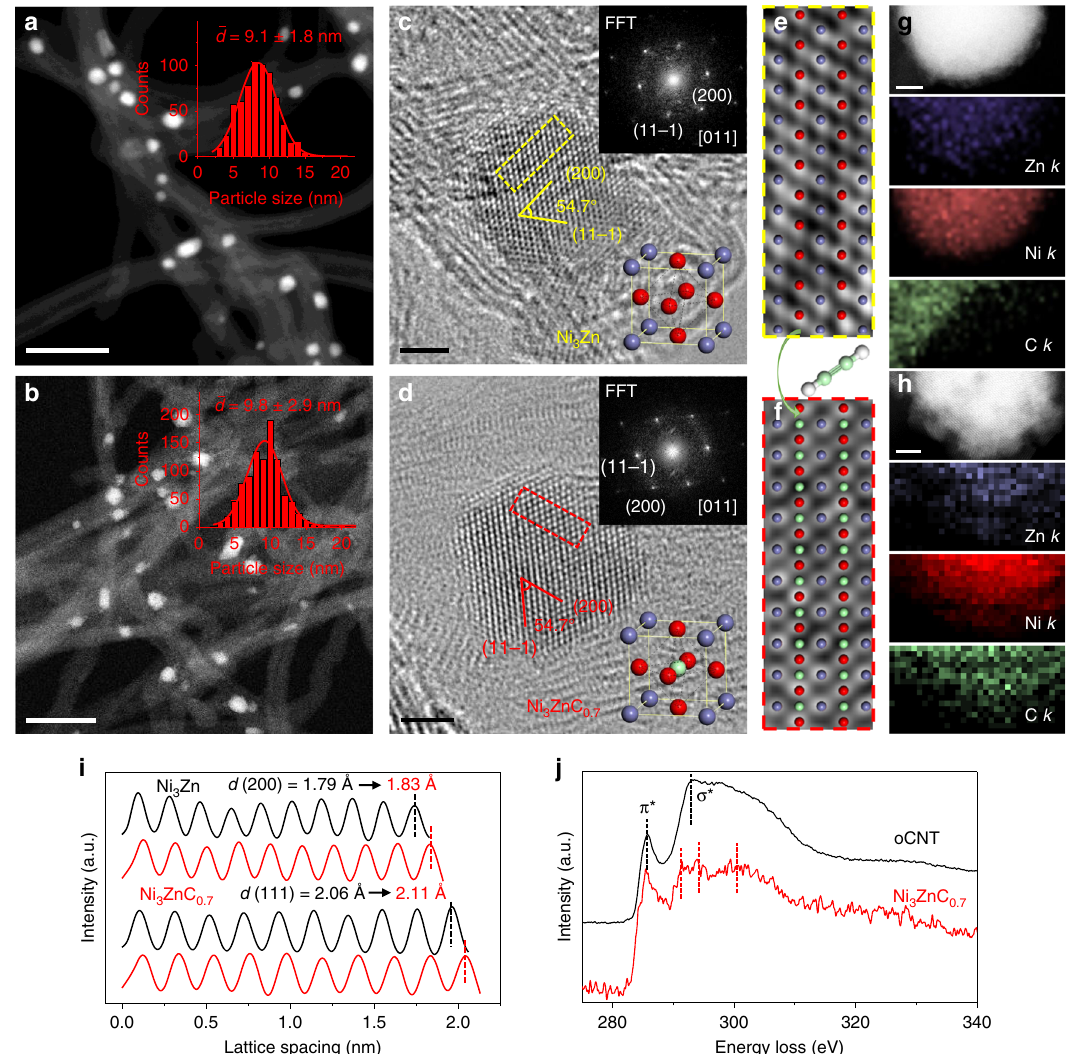
Fig. 2 Microstructural characterization of Ni 3 Zn and Ni 3 ZnC 0.7 . STEM images of Ni 3 Zn/oCNT ( a ) and Ni 3 ZnC 0.7 /oCNT ( b ), the right-top insets are the corresponding particle size distribution diagrams. HRTEM images of Ni 3 Zn ( c ) and Ni 3 ZnC 0.7 ( d ). The top-right and bottom-right insets correspond to the FFTs and unit cells. e – f The atomic model overlapped with the HRTEM images acquired from the dashed box in c , d . High-resolution STEM images of Ni 3 Zn ( g ) and Ni 3 ZnC 0.7 ( h ) with the corresponding EDX elemental mapping of Ni (red), Zn (purple), and C (green). i The integrated intensities of Ni 3 Zn and Ni 3 ZnC 0.7 perpendicular to the (11 − 1) and (200) planes. j C K-edge EEL spectra of oCNT and Ni 3 ZnC 0.7 . Scale bars: 50 nm in a , b and 2 nm in c , d , g , h